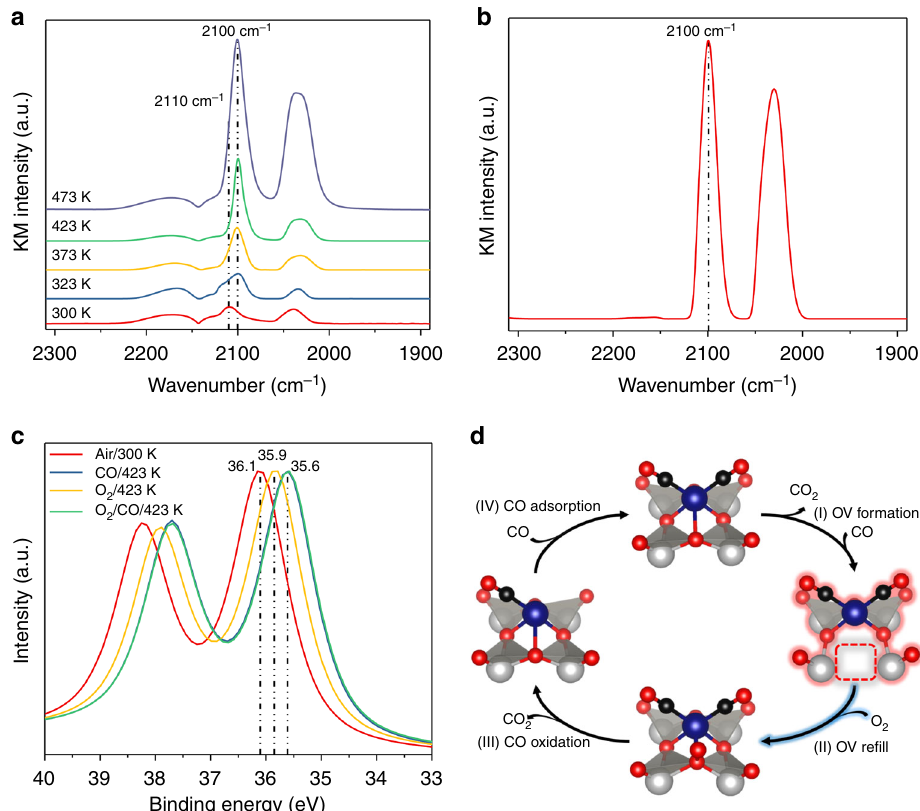
Fig. 4 In situ DRIFT and XPS spectroscopy and proposed reaction cycle. CO DRIFT spectra of a the catalyst under CO at increasing temperatures (from bottom to top) and b of the catalyst under CO/O 2 at 473 K. c In situ W 4 f 7/2 XPS spectra of the catalyst under different gas atmospheres and temperatures. d Key steps of the proposed reaction mechanism based on in situ spectroscopy; the steady-state catalyst structure and the corresponding rate-controlling step are highlighted. Atom colors: W (gray), O (red), C (black), Rh (blue); OV stands for oxygen